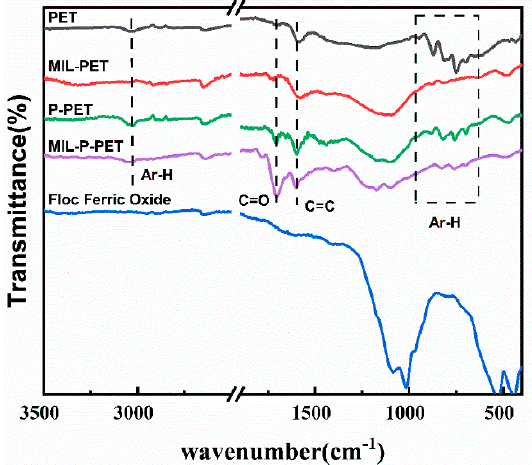
Figure 7. FTIR spectra of the char residue of PET, MIL − PET, P − PET, MIL − P −